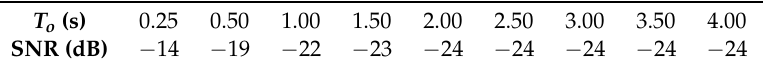
Table 1. Minimum SNR obtained for the estimation of the input signal amplitude with an uncertainty less than 10%. The SNR is provided as a function of the observation window T o